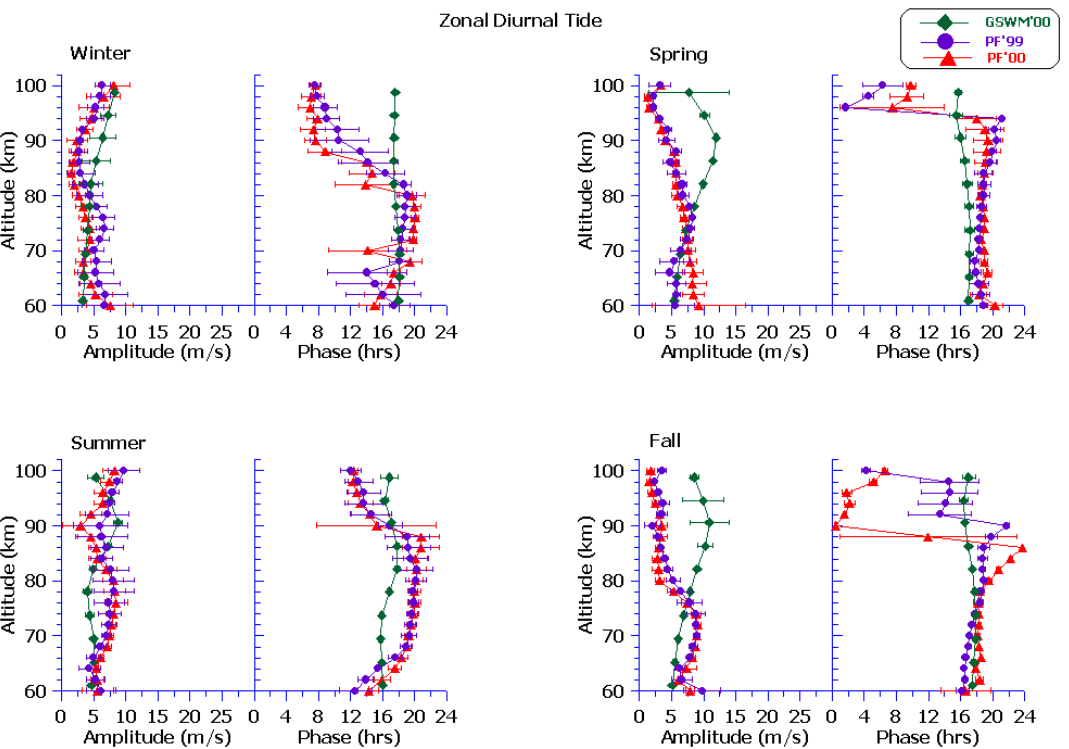
Fig. 11. Height profiles of the amplitudes and phases of the zonal wind component of the diurnal tide during summer, winter, spring, and fall seasons. Data shown are for the years 1999 and 2000. GSWM00 values are also given for comparison.